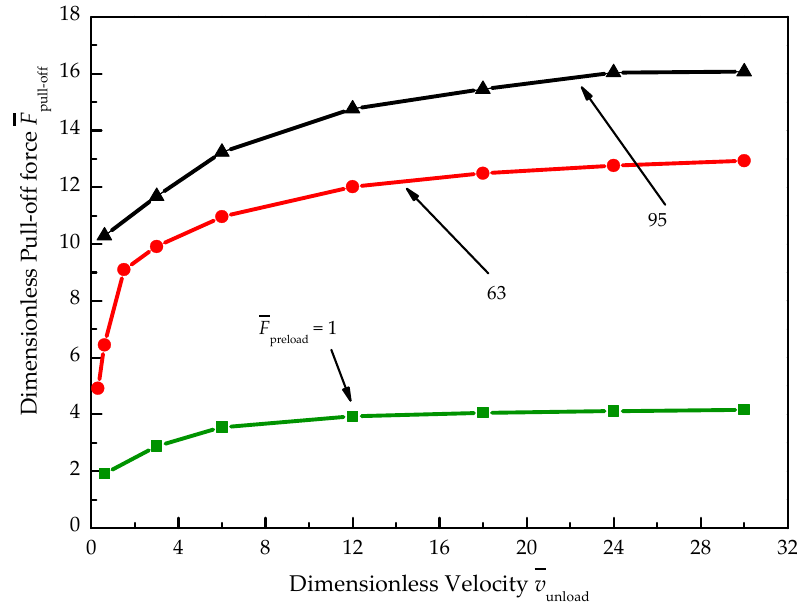
Figure 6. The effect of unloading velocity on pull-off force under the condition of Δ 𝛾̅ = 0.05.